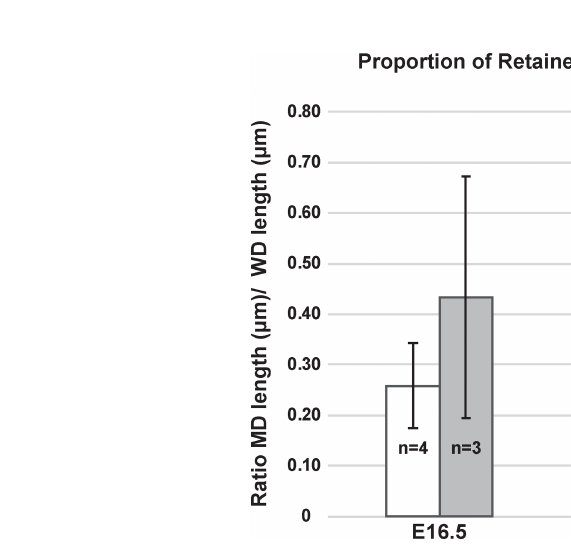
FIGURE 8 Proportion of retained Müllerian duct in Dlx5-6 mutant males is increased at E18.5 in comparison to controls. Quanti fi cation of the ratio of retained Müllerian duct epithelium length to Wolf fi an duct epithelium length in Dlx5-6/+ and Dlx5-6/Dlx5-6 males at E16.5 and E18.5. Data are presented as mean±standard deviation. Asterisk (*) indicates statistically signi fi cant difference ( p ≤